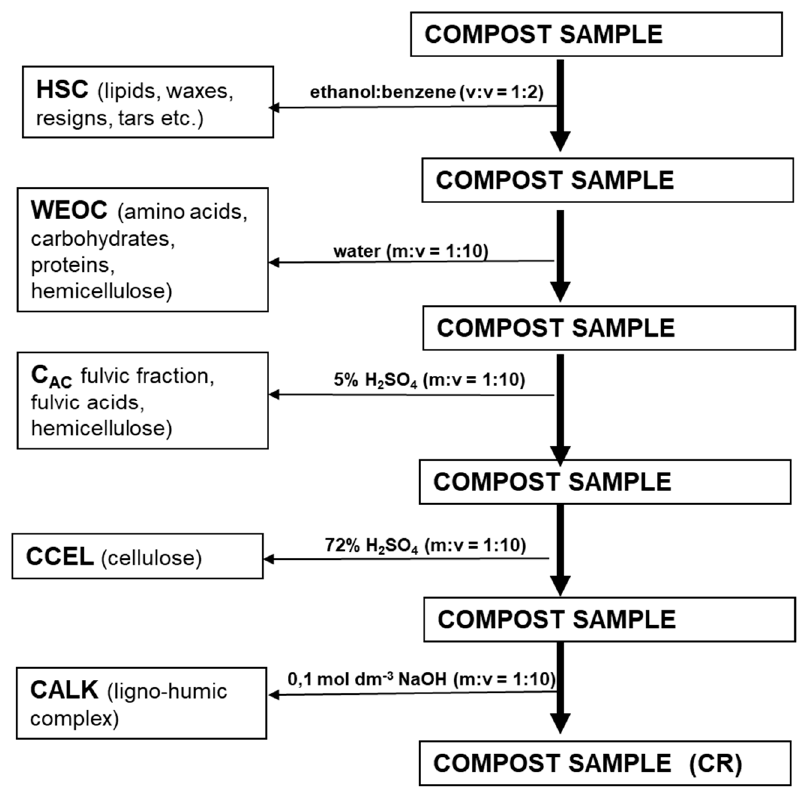
Figure 1. Simplified diagram of the extraction method by Stevenson [17] and Adani et al.